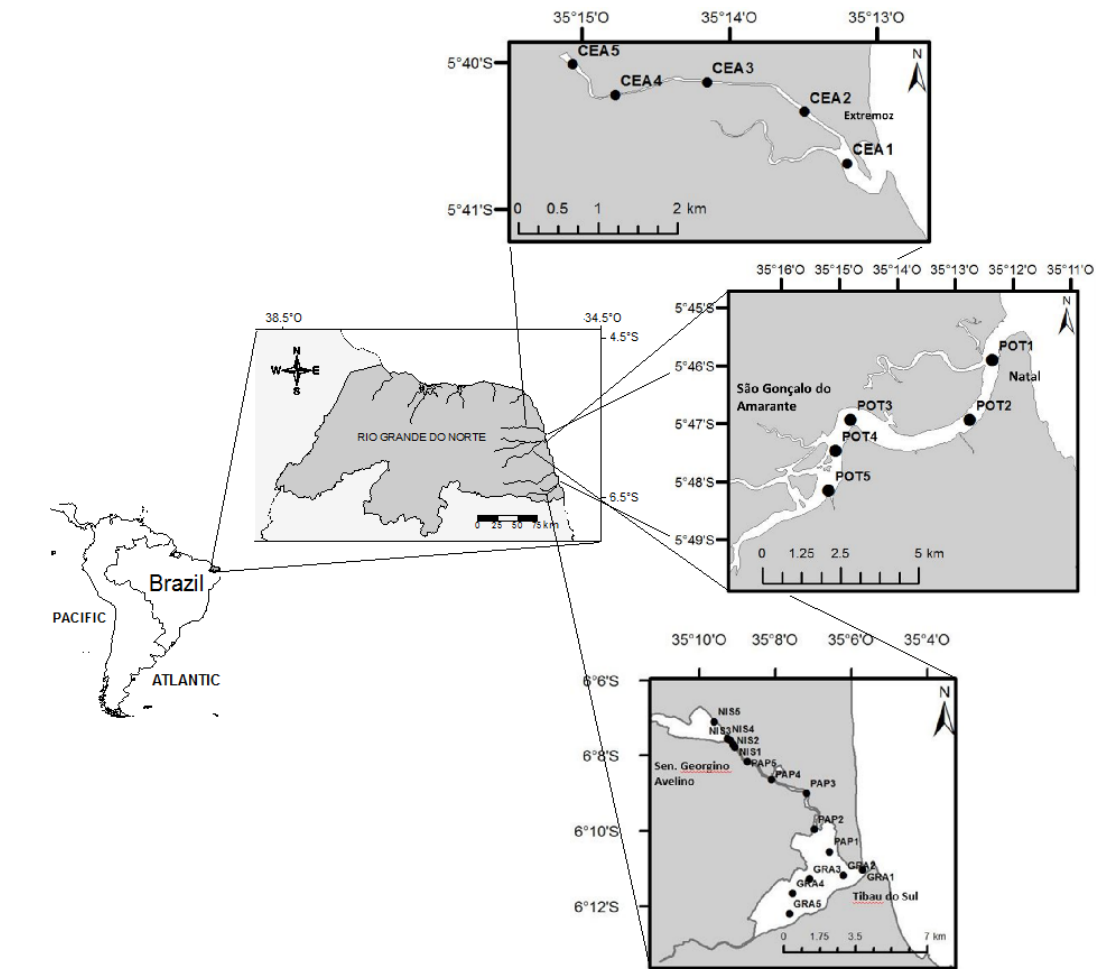
Figure 2 - Study area ( CEA - Ceara Mirim sampling stations / POT - Potengi sampling stations / NIS – Nísia-Floresta sampling stations / PAP – Papeba sampling stations / GRA – Guaraíra sampling